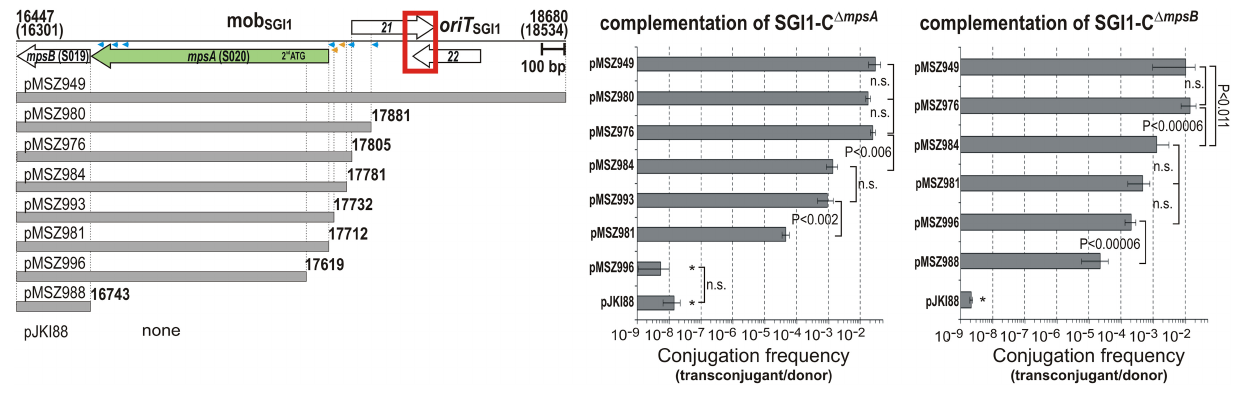
P mpsAB . Interestingly, like SGI1-C (cid:49) mpsA , the transfer of